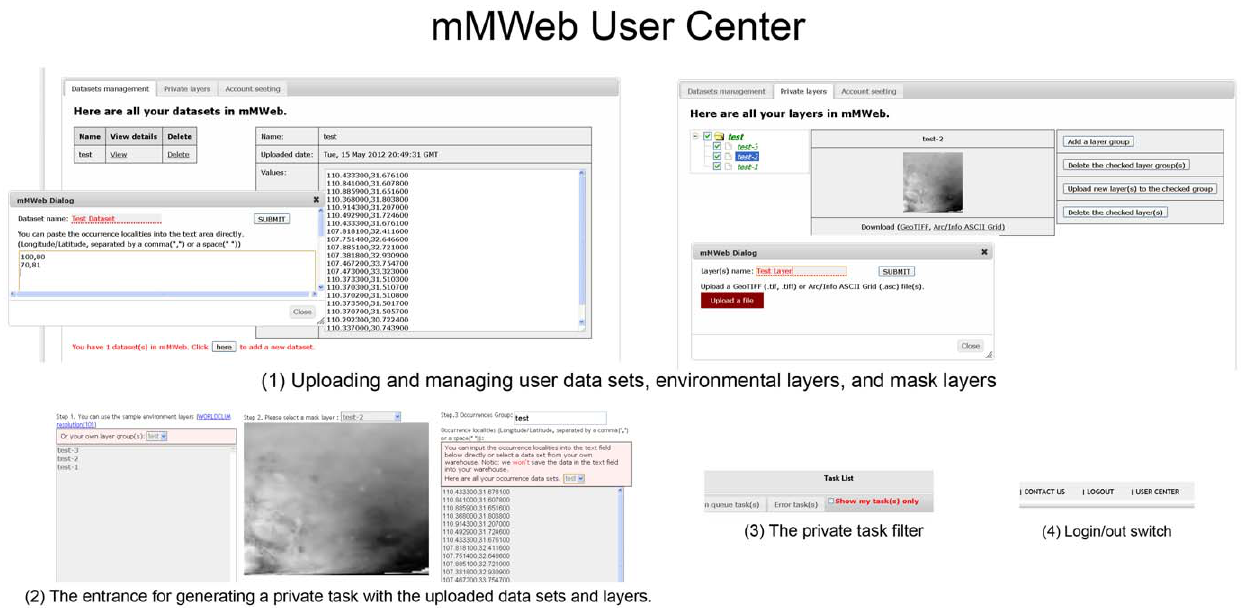
PLOS ONE | www.plosone.org 3 August 2012 | Volume 7 | Issue 8 |